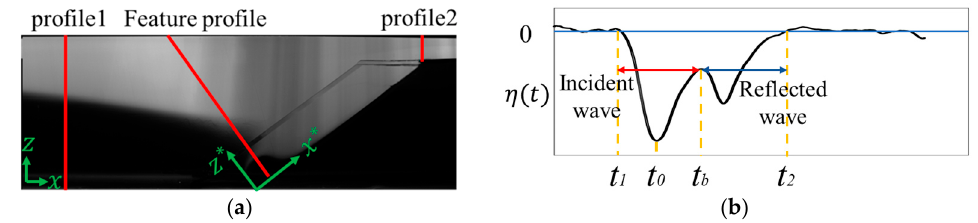
Figure 3. Determination of initial moment and characteristic period. ( a ) Experimental image and locations of featured profiles; ( b ) time series of pycnocline displacement 𝜂 in profile 1.